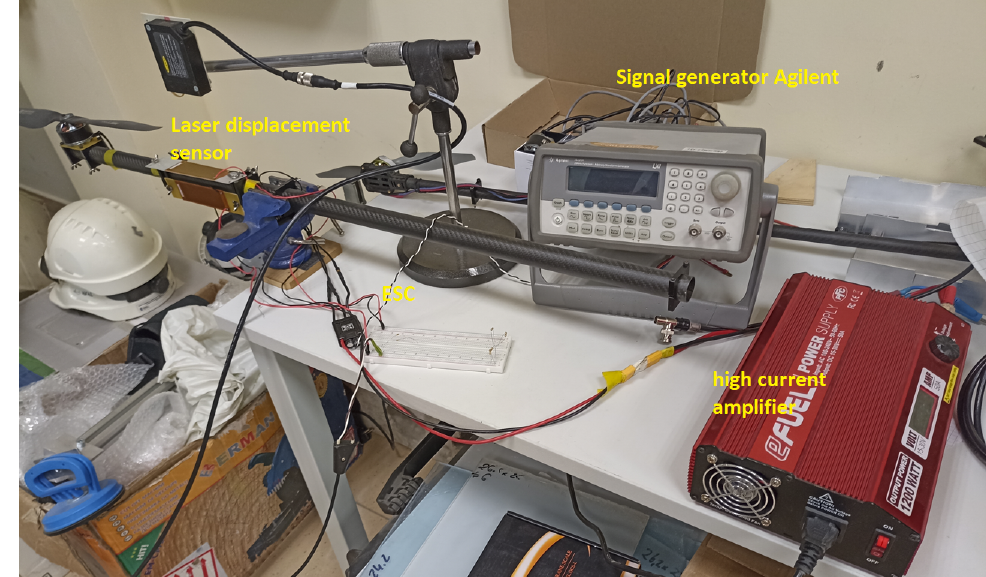
Figure 11. Laboratory test